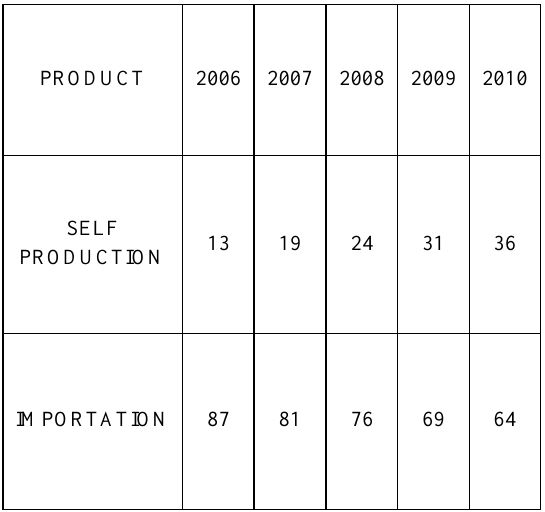
Table 5: 2006 - 2008 Pre-Crisis and 2008-2010 Post- Crisis Product Distribution (%) for XYZ